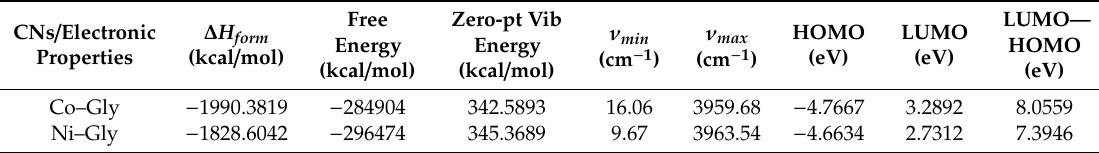
Table 7. The electronic properties of the CNs models.